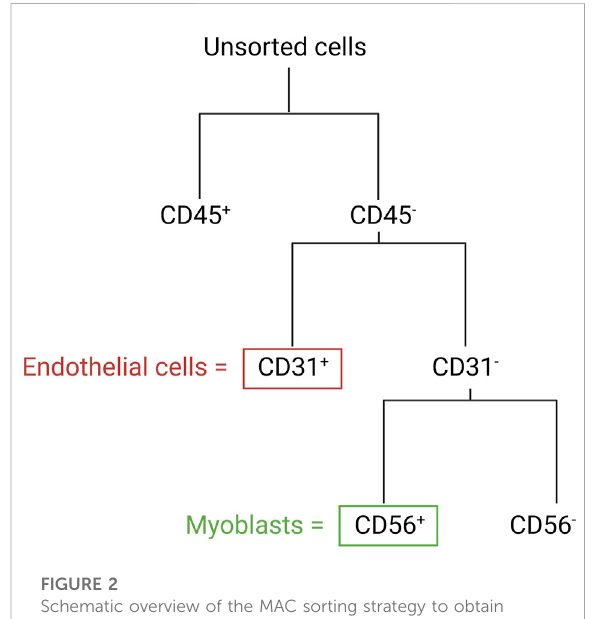
FIGURE 2 Schematic overview of the MAC sorting strategy to obtain endothelial cells (marker: CD31) and myoblasts (marker: CD56). Both cell types are isolated from the CD45-negative cell population (depleted cells of hematopoietic